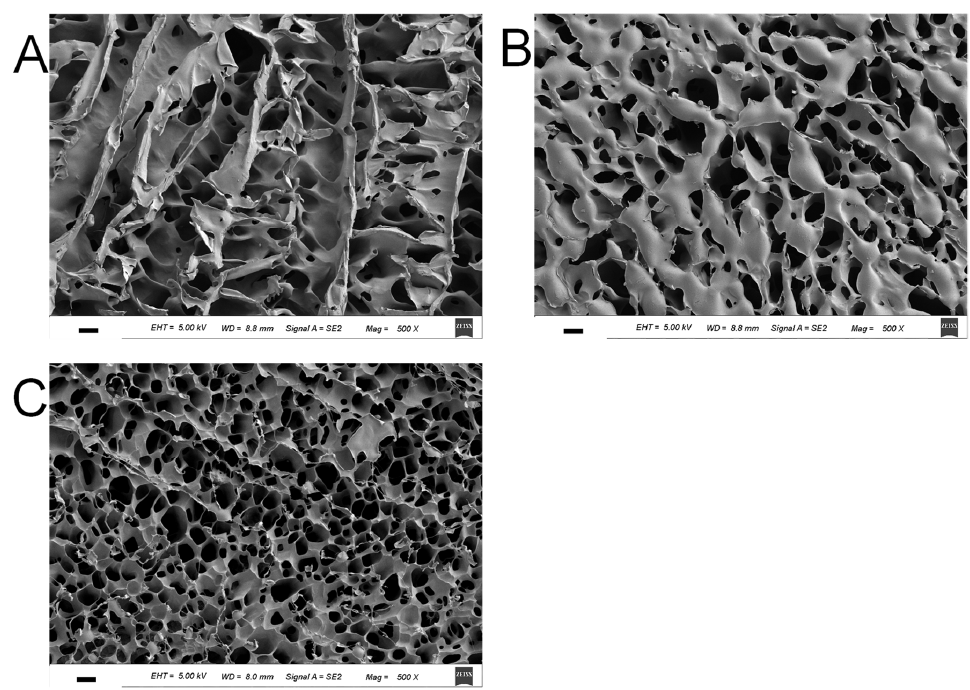
Figure 5. SEM images for the samples HC0 ( A ), HC2 ( B ), and HC6 ( C ). The scale bar is 10 μm.